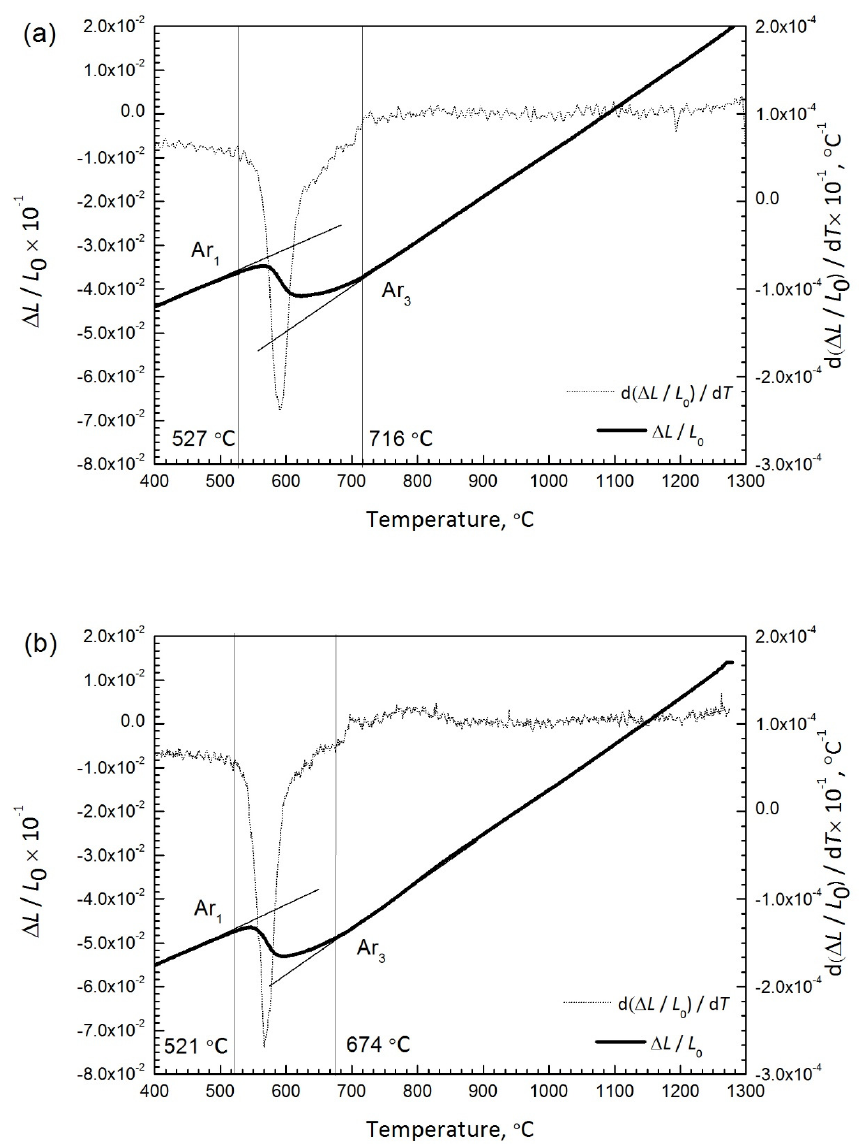
Figure 13. On cooling dilatation recordings and the corresponding derivative for the air-cooled initial microstructure ( a ), and for the water-quenched initial microstructure ( b ).